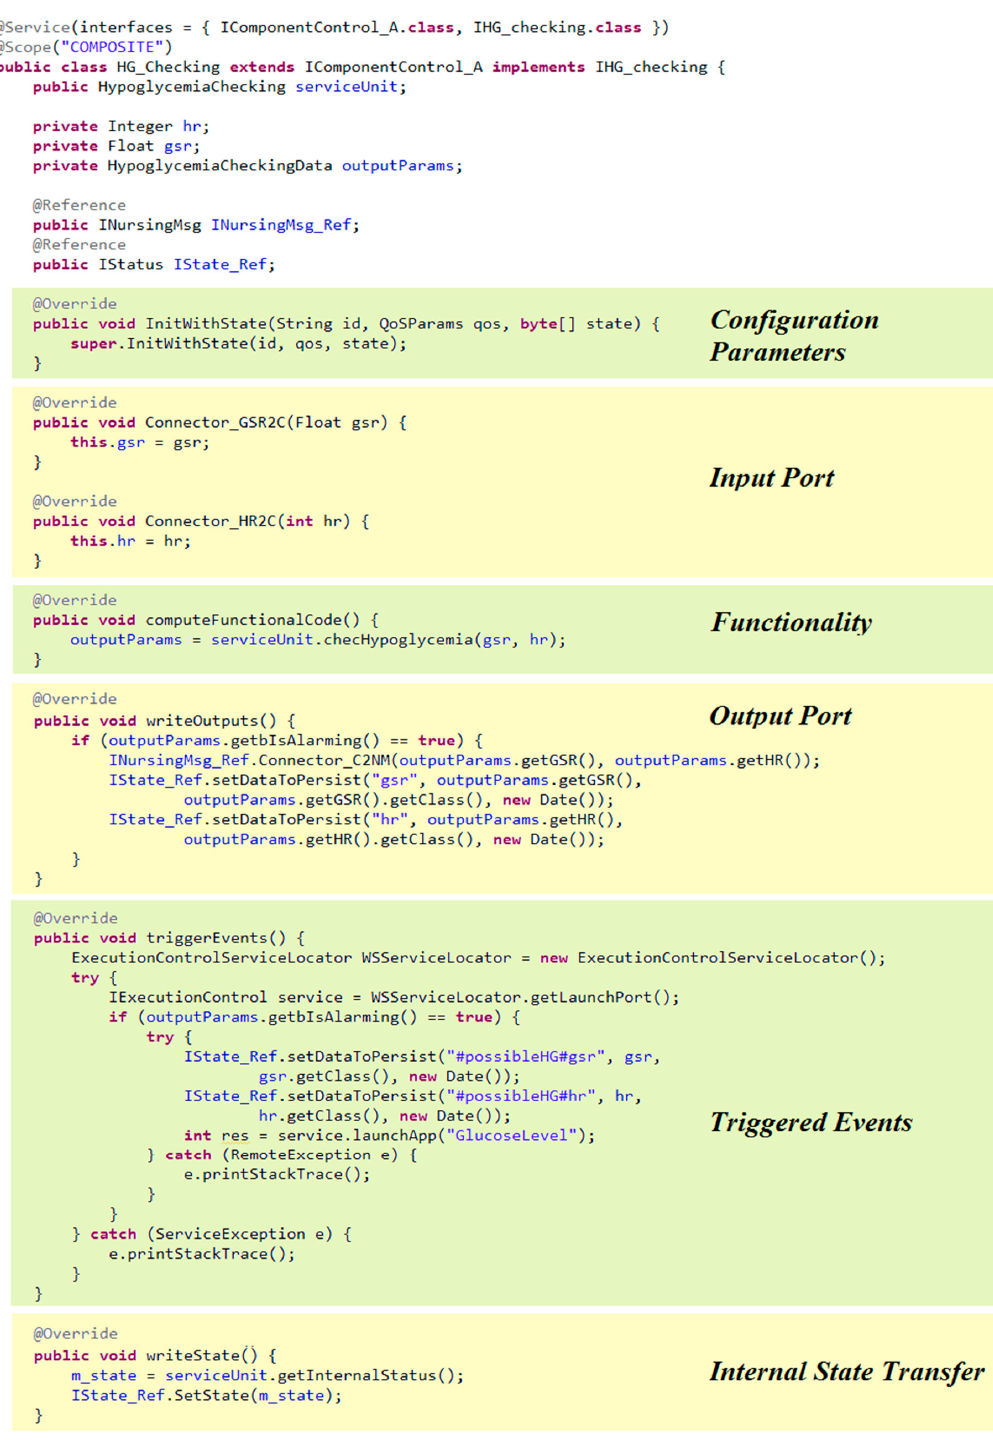
Figure 13 . HG_Checking component implementation. Figure 13. HG_Checking component